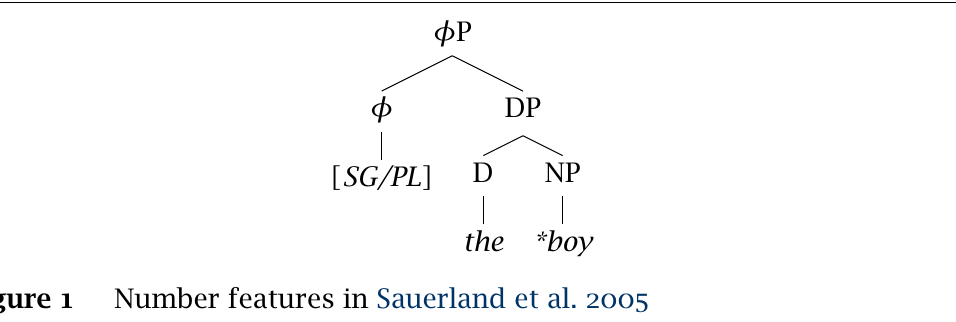
Figure 1 Number features in Sauerland et al.